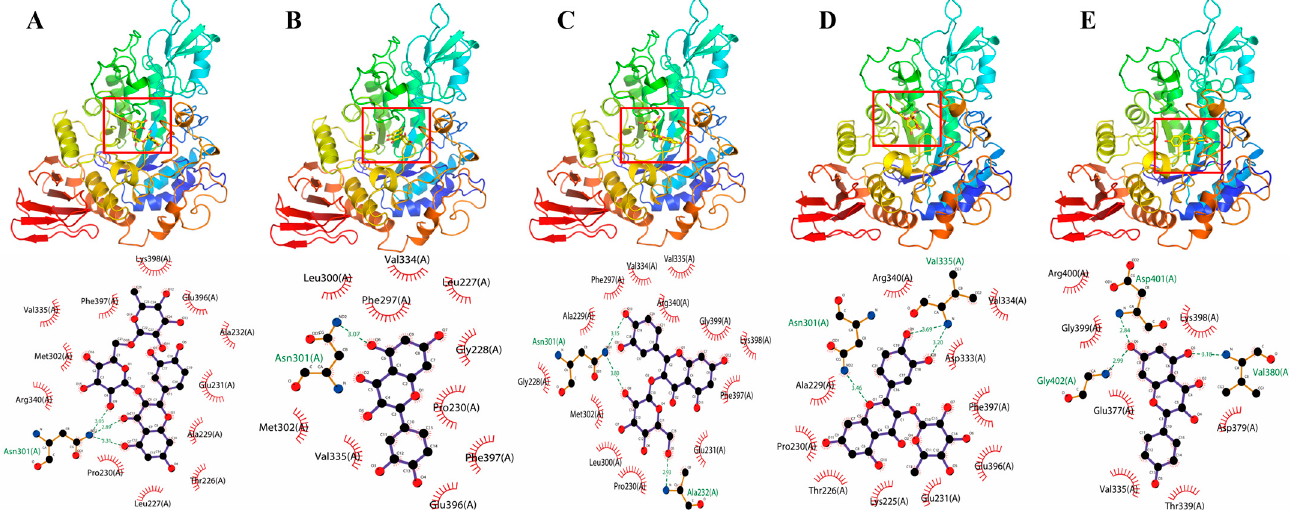
Figure 5. Three-dimensional and two-dimensional docking modes of RU ( A ), QU ( B ), HY ( C ), QI ( D ) and KA ( E ) with α -glucosidase by molecular docking. RU represents rutin, QU represents quercetin, HY represents hyperoside, QI represents quercitrin, KA represents, kaempferol.